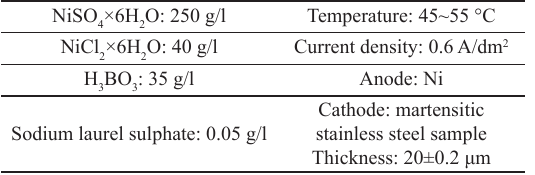
Table 1. Composition of the depositing solution and the depositing parameters.